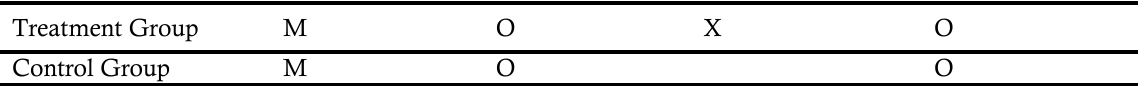
Table 1. The matching-only pretest-posttest control group